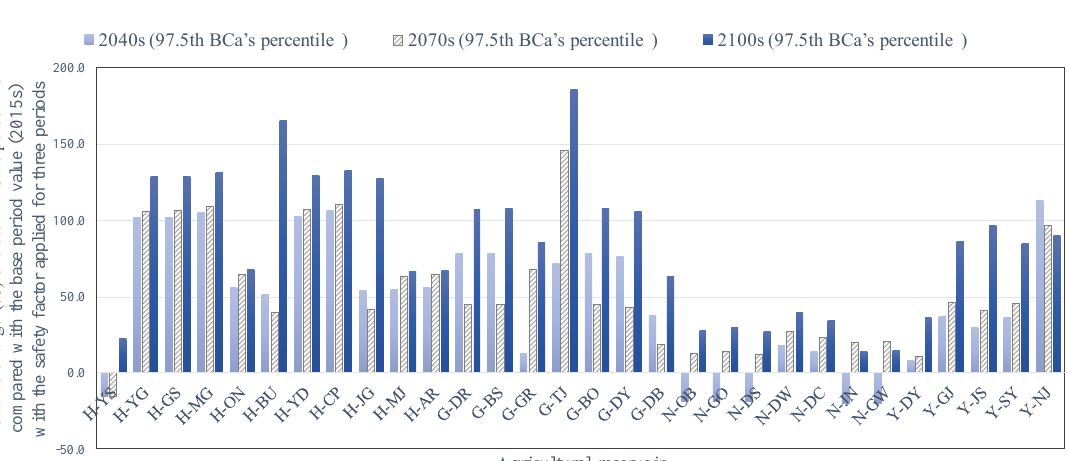
Figure 11. Relative change (%) of 97.5th BC a percentile of the inflow design flood bootstrap sampling distribution compared with the base period value (2015s) with the safety factor (1.2 times) applied for three future periods under the RCP4.5 scenario for 30 agricultural reservoir watersheds. Refer to Table 1 for reservoir names.